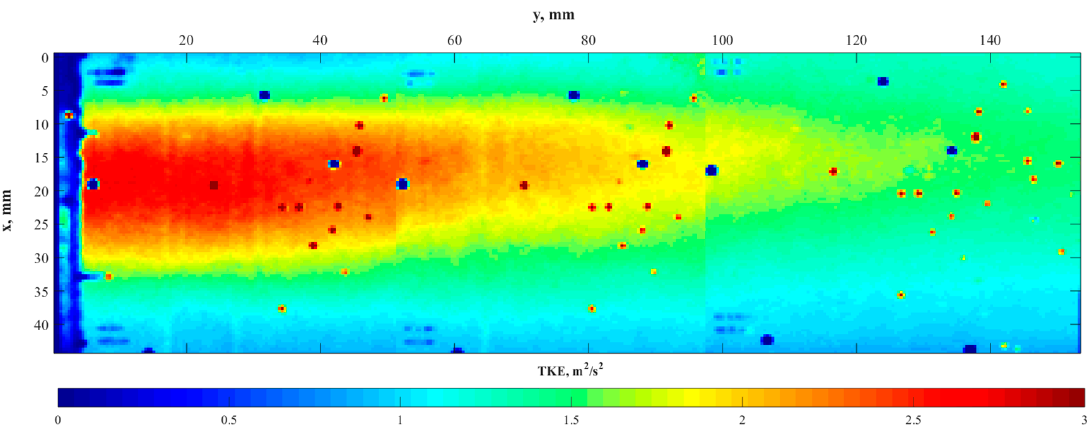
Figure 8. Contour of the time-averaged TKE measured by PIV at 1.4 m/s stream velocity.